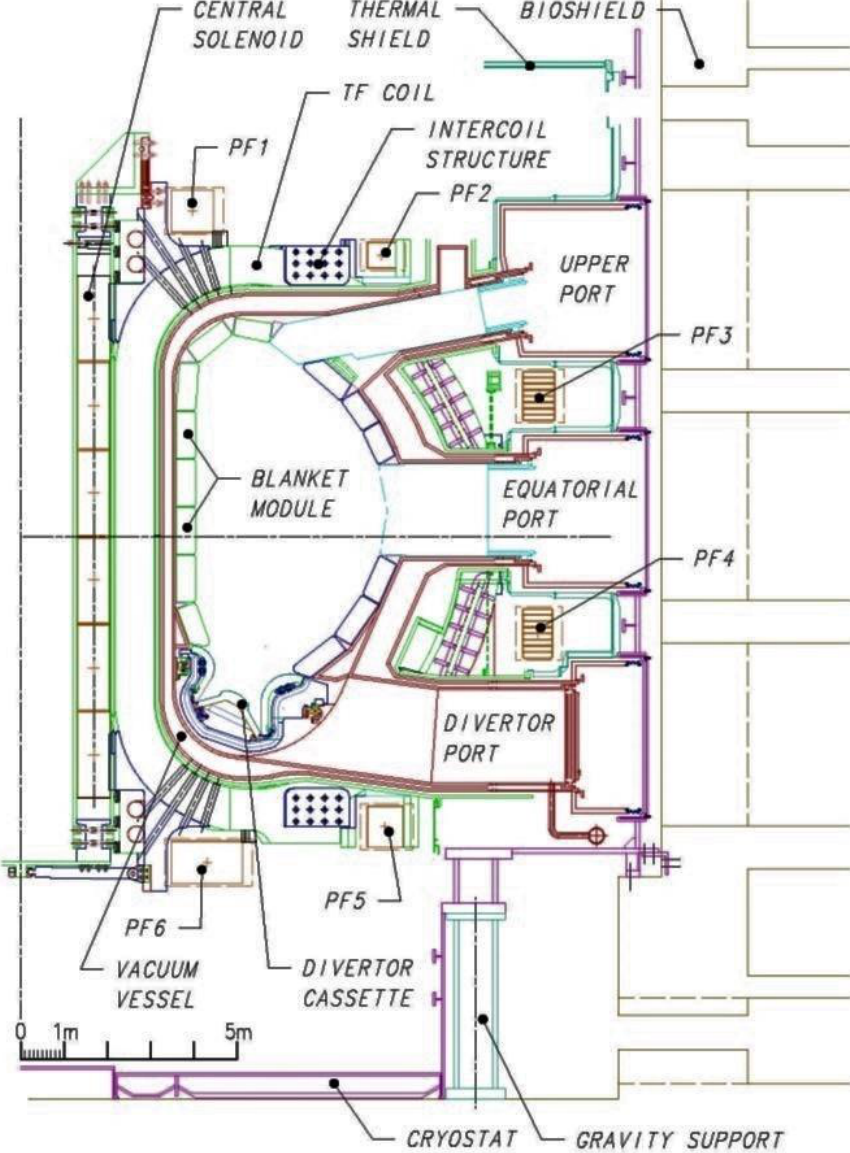
Figure 4. Vertical cross section of the ITER Tokamak. TF = toroidal field; PF = poloidal field. The six poloidal field coils that are used to shape the plasma are depicted as PF1, PF2, . . . , PF6 (from ITER Technical Basis [4]). © 2002 IAEA.